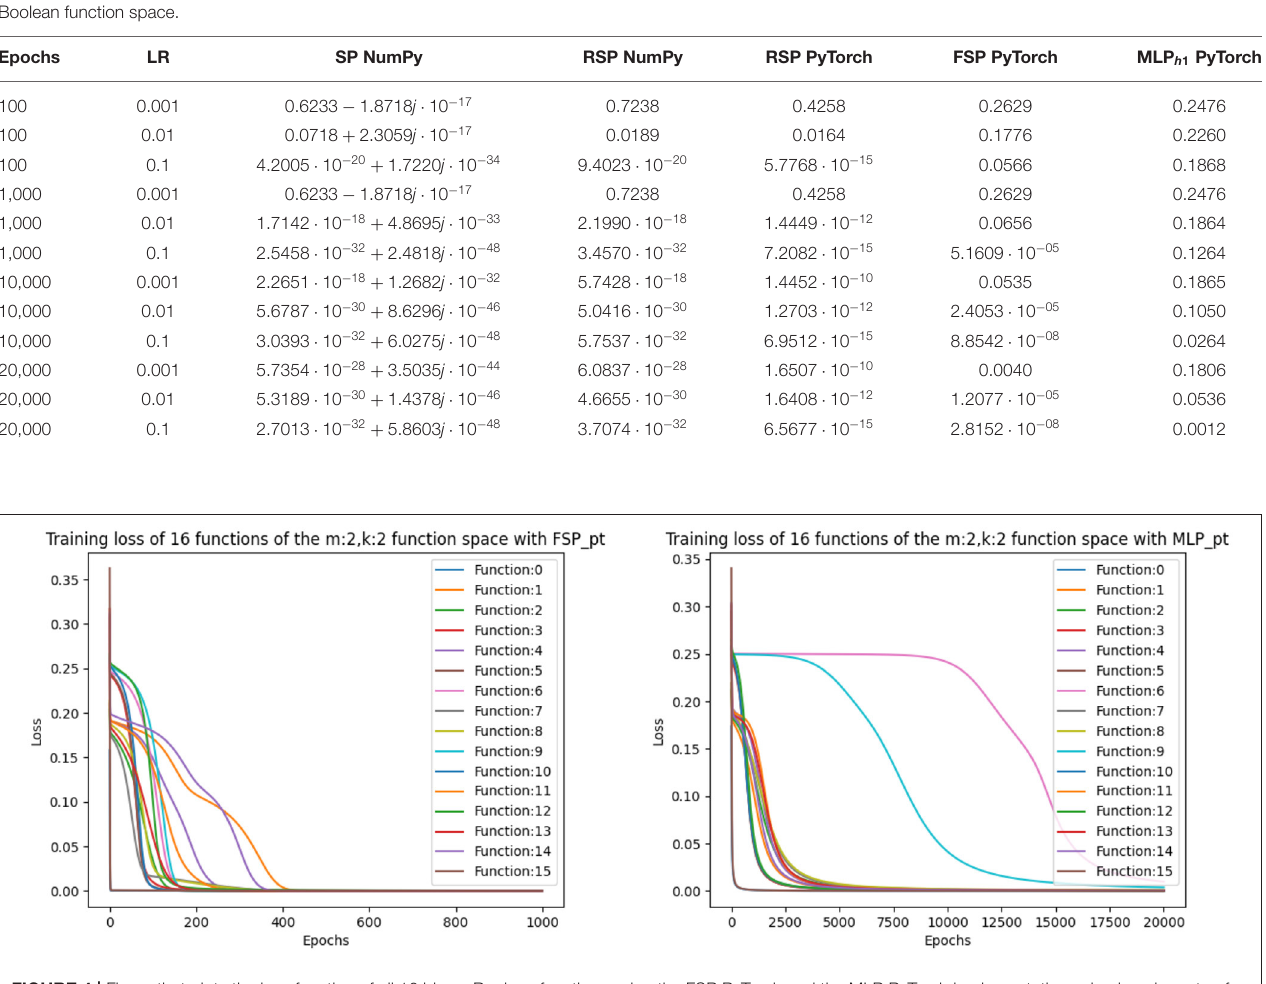
FIGURE 4 | Figure that plots the loss function of all 16 binary Boolean functions using the FSP PyTorch and the MLP PyTorch implementation using learning rate of 0.1. The graph on the right shows that even after 20,000 epochs, the MLP cannot exactly learn some of the functions.